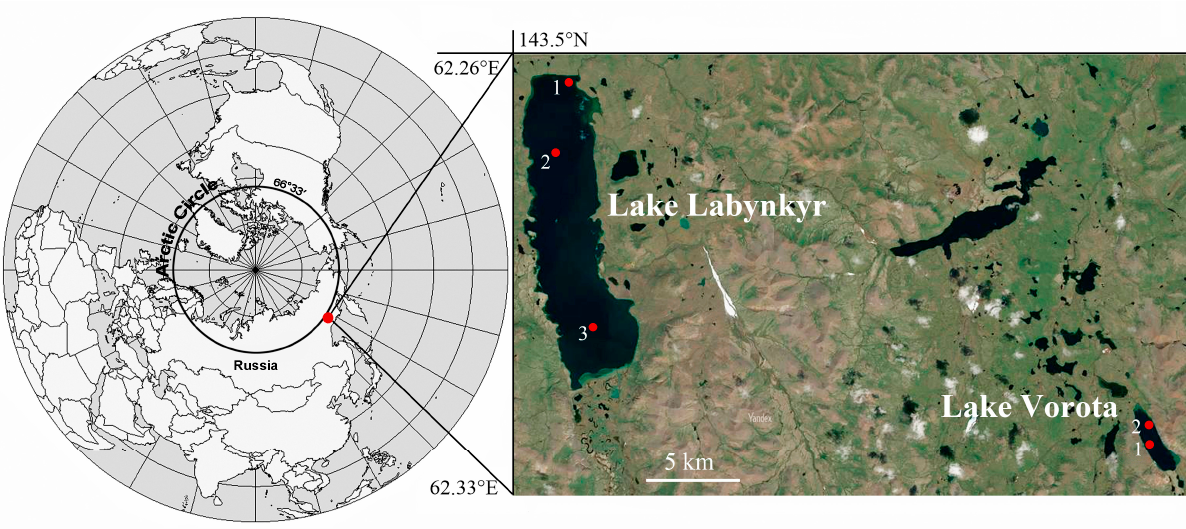
Figure 1. The map of the study regions and sampling site locations.